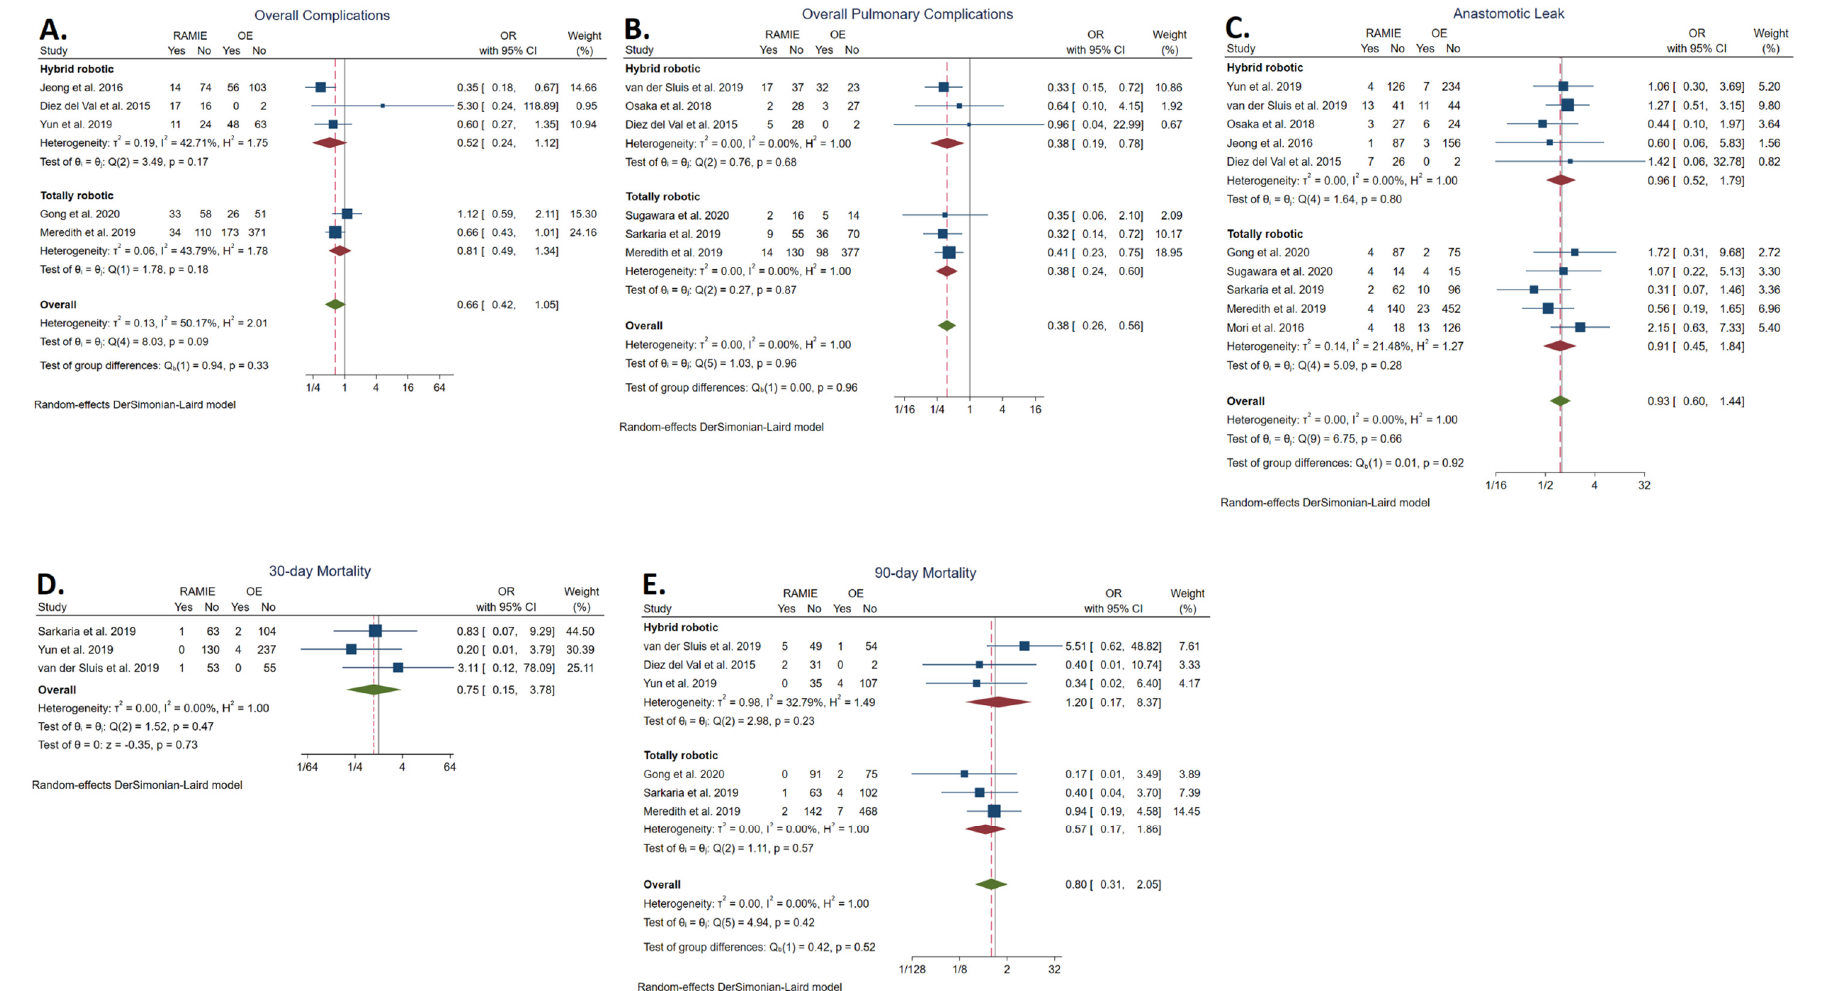
Figure 2. Forest plots of overall complication rate ( A ), overall pulmonary complication rate ( B ), anastomotic leakage rate ( C ), 30-day mortality rate ( D ), and 90-day mortality rate ( E ) [21,23–25,34–41].